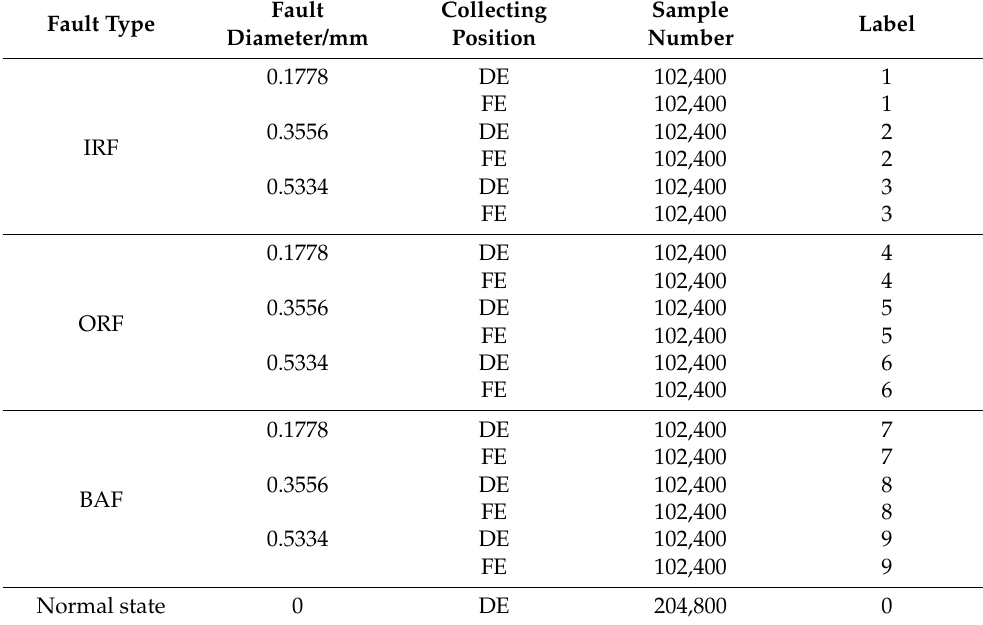
Table 1. Experimental data of rolling